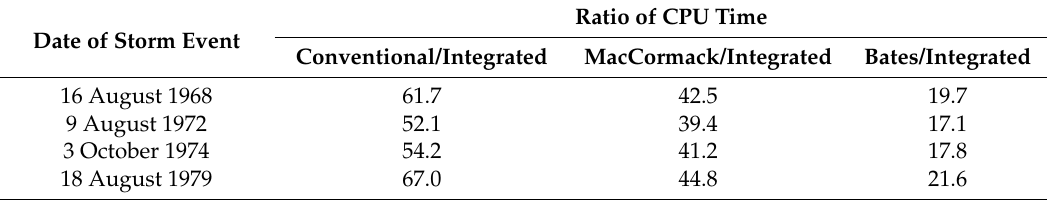
Table 3. Evaluation of computational efficiency for different algorithms.